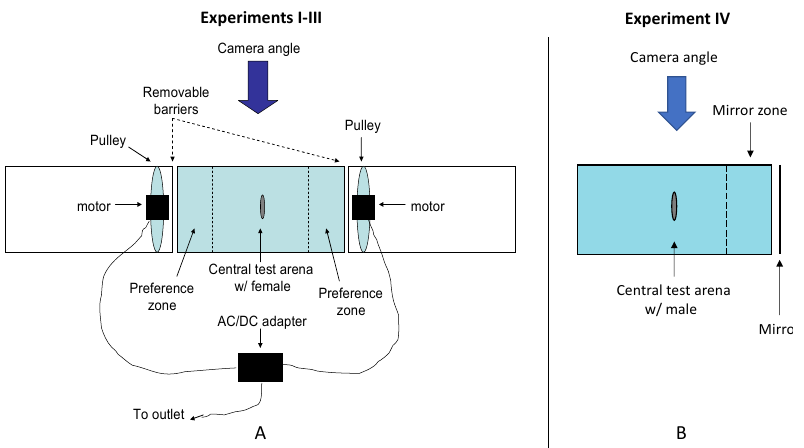
Figure 2. Diagram of apparatus and arenas used for all experiments. ( A ) Apparatus and arena used for expts. I ‐ III: The subject was placed between a pair of aquaria each housing an adjustable motorized belt and pulley system. The dummy stimuli were attached to the pulley systems situated in the aquaria flanking the central test arena for all behavioral assays. When the apparatus was turned on, the dummy fish began ‘pacing’ back and forth along the glass facing the test arena. An iPad was used to record the subject’s behavior; ( B ) Arena set up used for expt. IV. Note: Dimensions of the test arena were the same for all experiments.